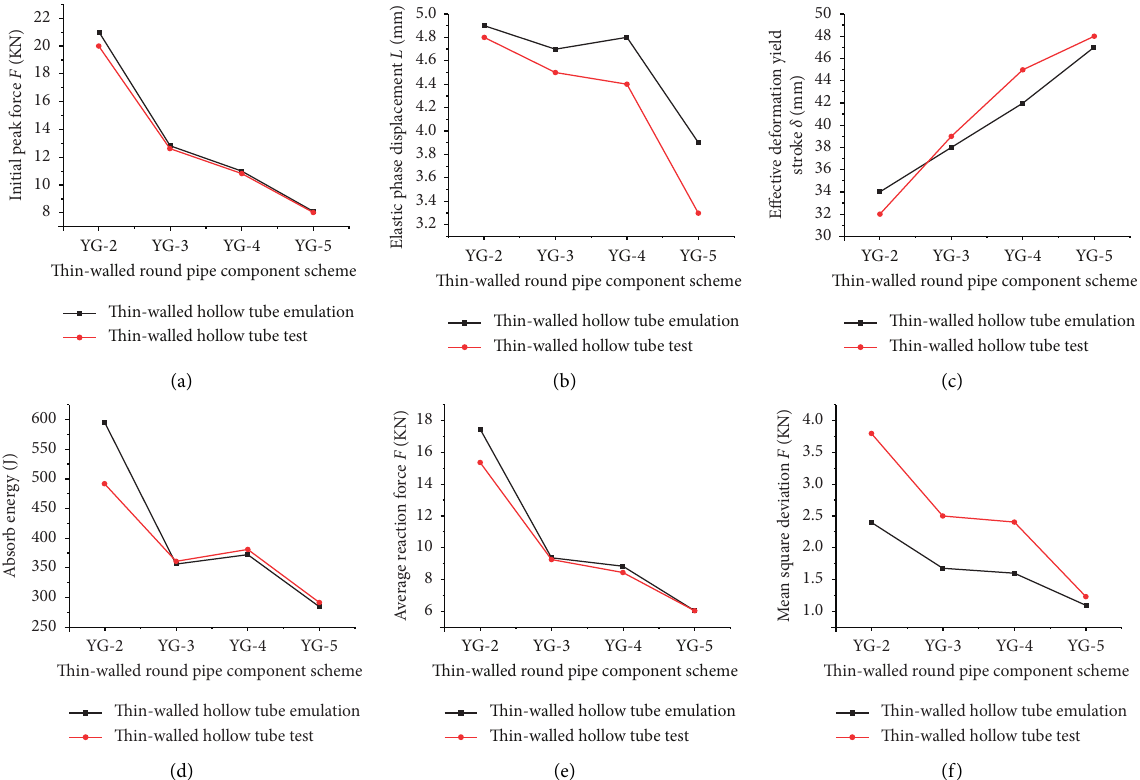
Figure 11: The performance evaluation parameters of the crushing buckling test and simulation of each scheme member. (a) Initial peak force, (b) elastic phase displacement, (c) effective deformation yield stroke, (d) absorb energy, (e) average reaction force, and (f) mean square